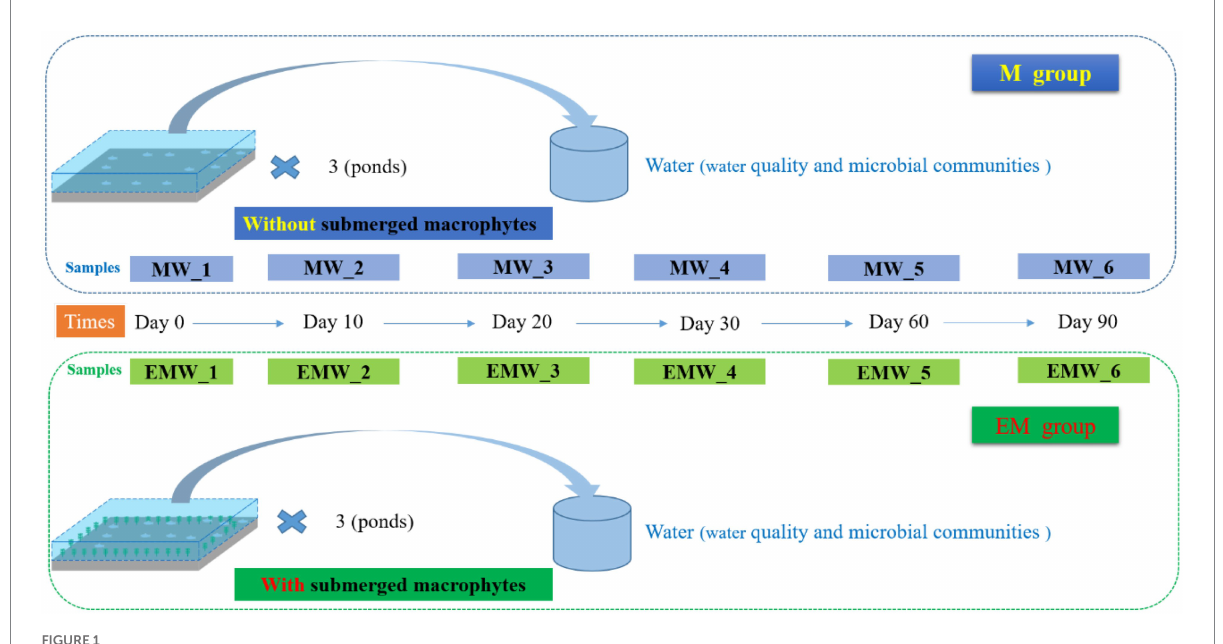
FIGURE 1 A diagram of the experimental design